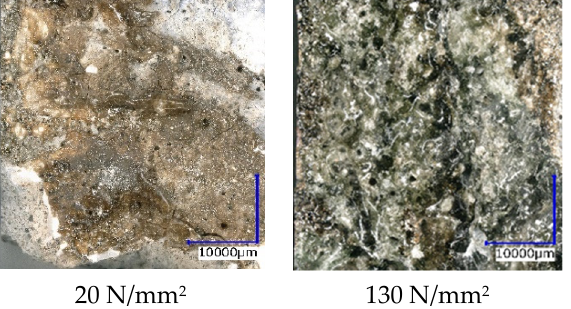
Figure 7. Cut surface after irradiation.